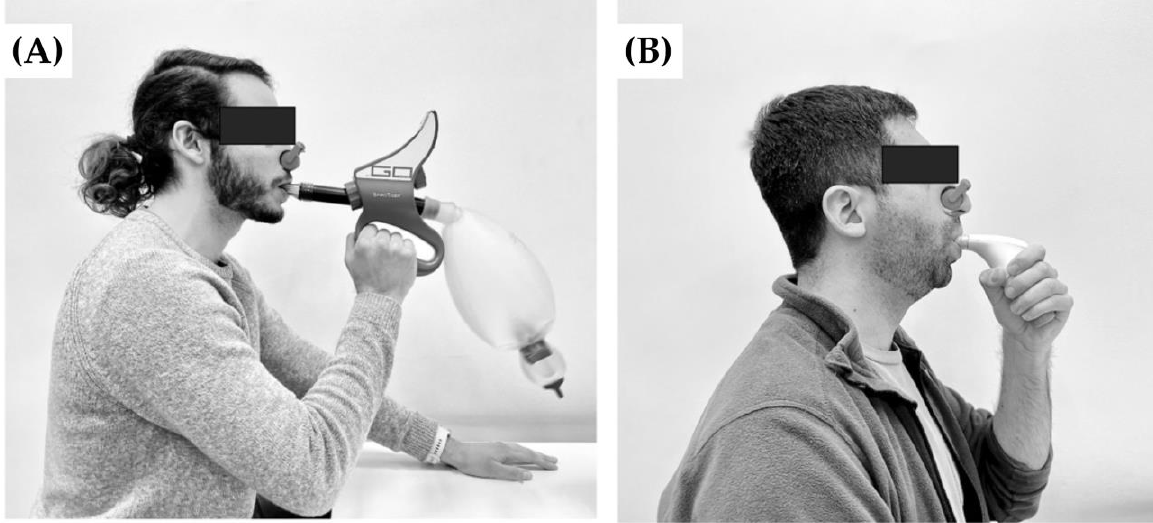
Figure 1. Type and devices used in the Respiratory Muscle Training (RMT): ( A ) Voluntary Isocapnic Hyperpnea (VIH) by SpiroTiger™; and ( B ) Inspiratory Threshold Loading (ITL) by POWERbreathe plus ® .